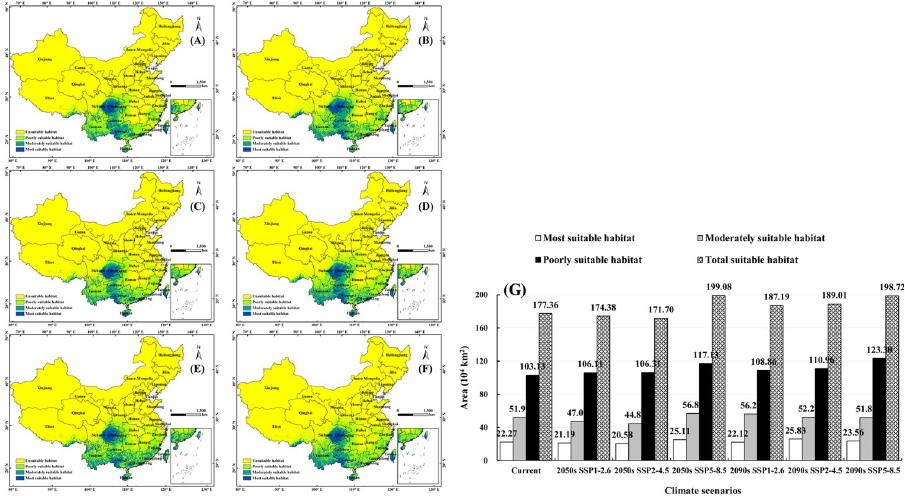
Fig 3. Suitable habitats simulated by MaxEnt under climate change scenarios. (A): 2050s, SSP1-2.6; (B): 2090s, SSP1-2.6; (C): 2050s, SSP2-4.5; (D): 2090s, SSP2-4.5; (E): 2050s, SSP5-8.5; (F): 2090s, SSP5-8.5; (G): Areas of suitable habitat under climate change scenarios. The boundary was obtained from Natural Earth (http://www.naturalearthdata. com/). Based on the principle of national and territorial integrity, we have modified and adjusted the vector boundary.